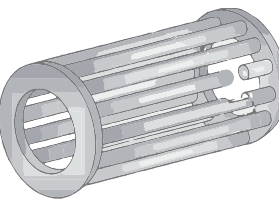
Figure 2. Broken rotor bar.